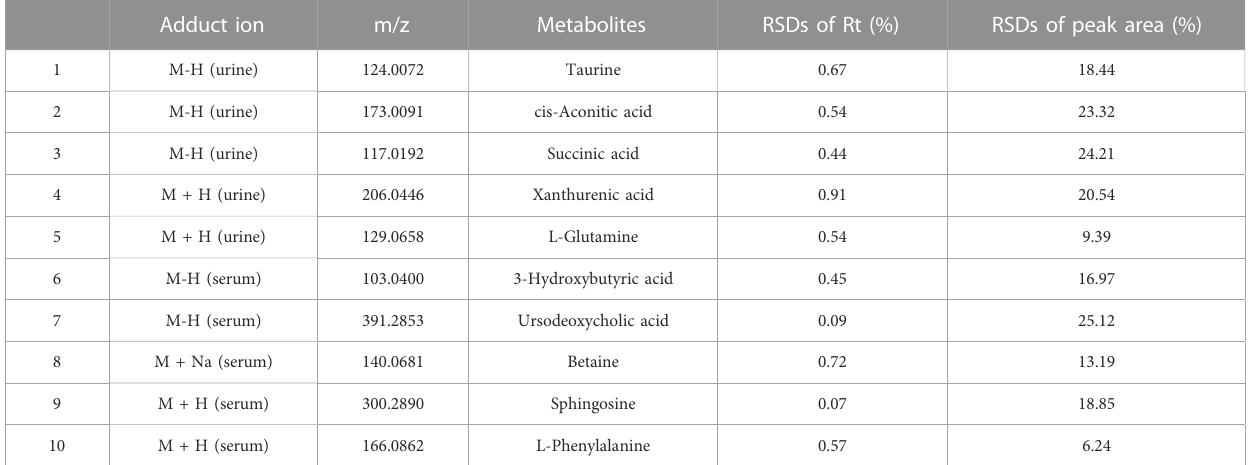
TABLE 1 RSDs of retention times and peak areas of ten potential biomarkers extracted from urine and serum of